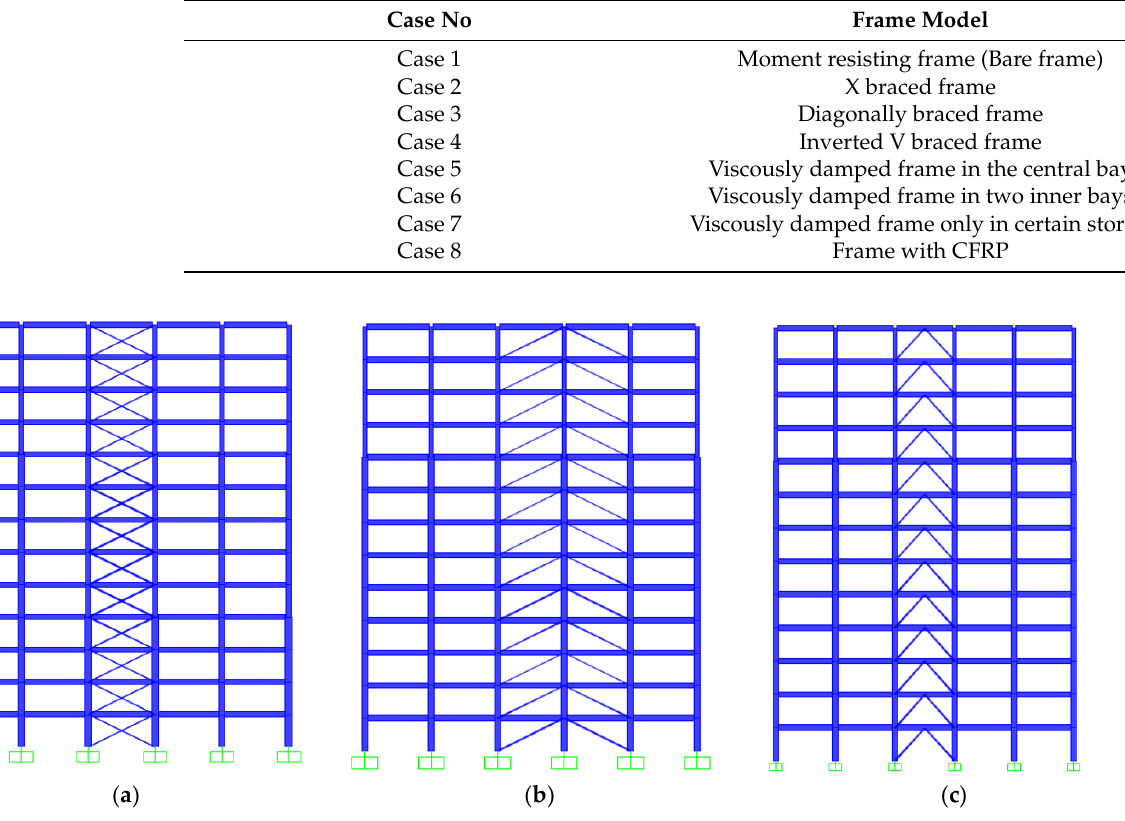
Figure 3. ( a ) X-braced frame; ( b ) Diagonally braced frame, and ( c ) Inverted V-braced frame.